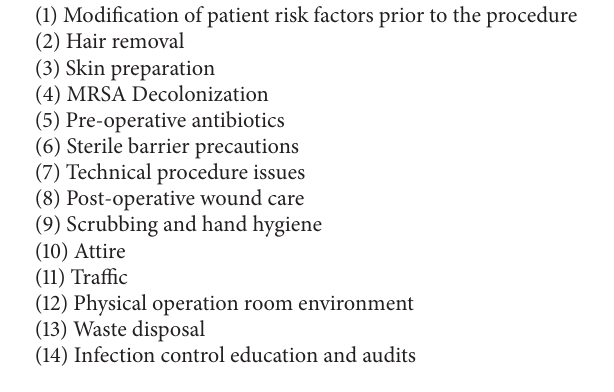
Box 1: Infection prevention measures for the prevention of cardiac implantable electronic device (CIED)